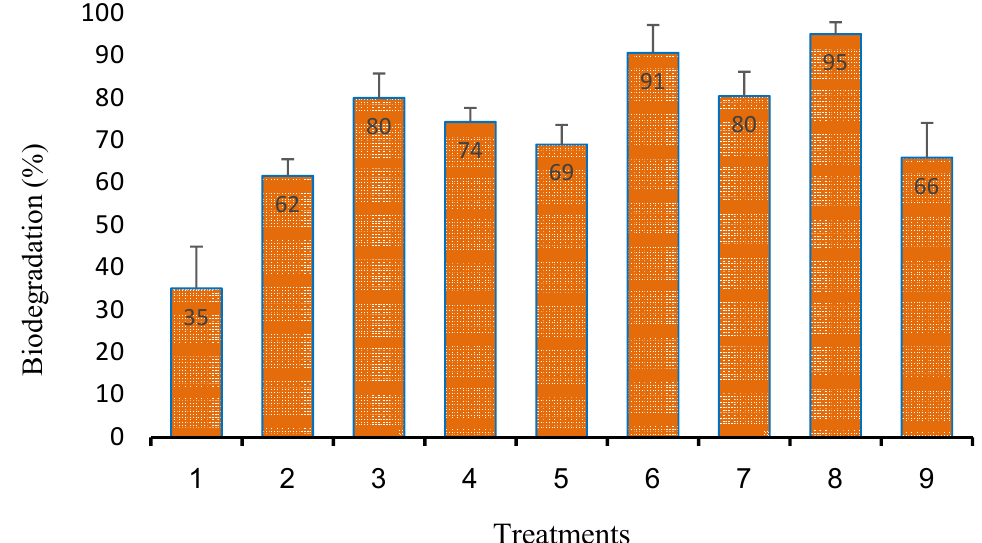
Fig. 1: Phenol degradation percentage by strain O‐CH1 in different treatments